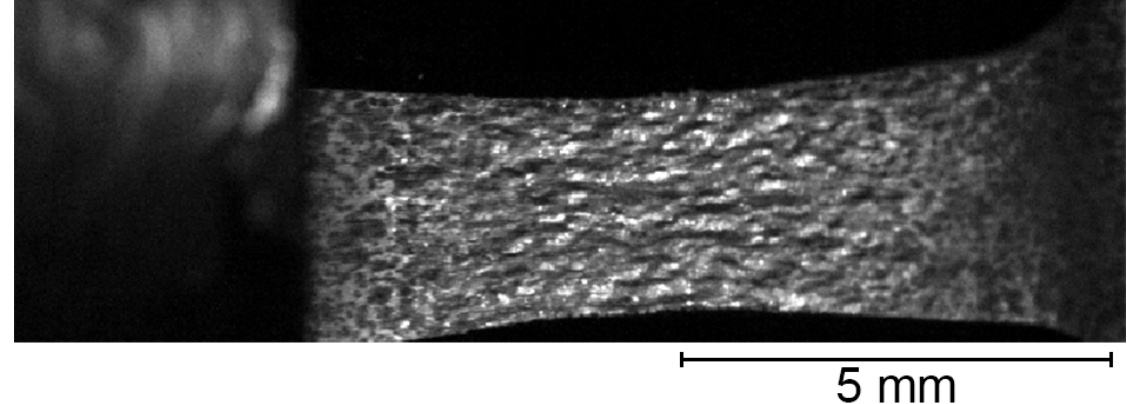
Figure 10. Optical image of the rough surface developed during deformation at 1120 °C.